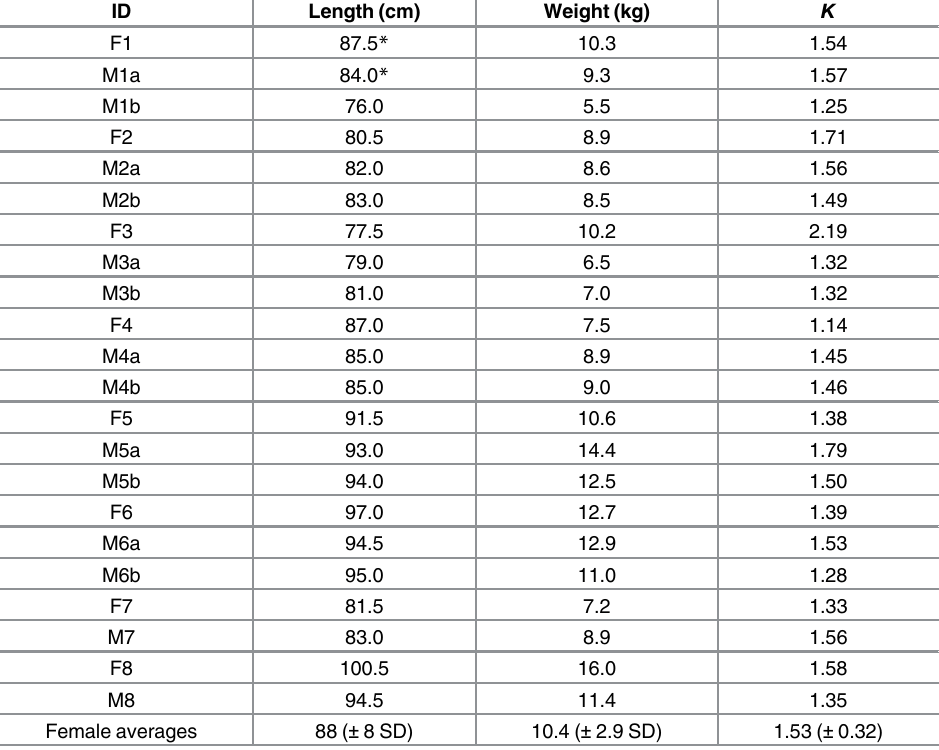
Table 1. Mating design and sizes of pre-spawning